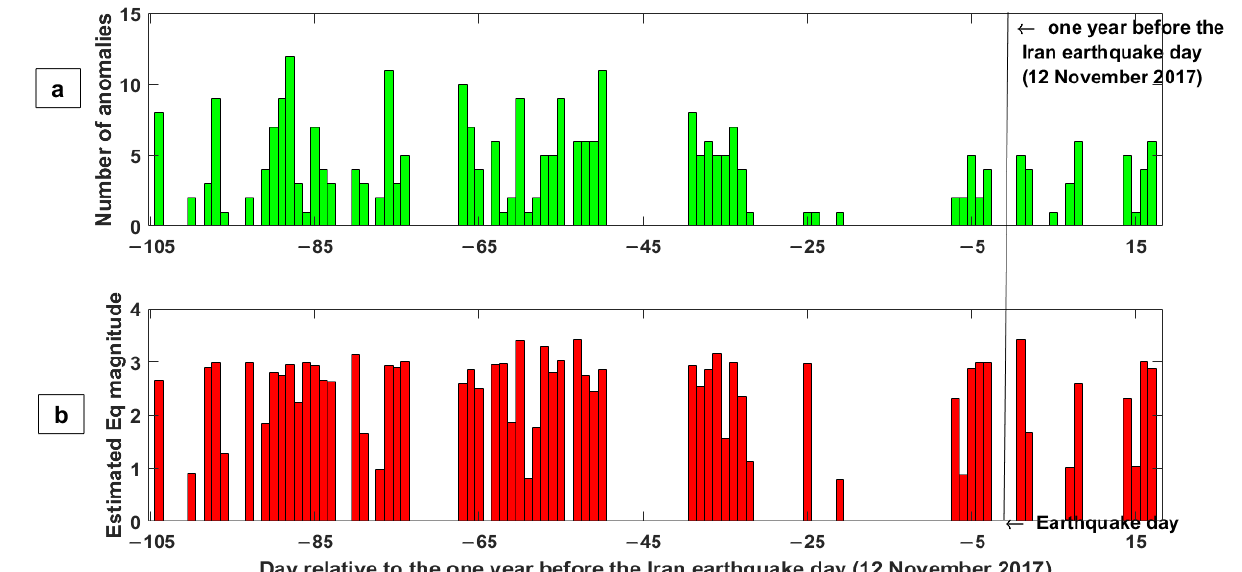
Figure 11. Validation analysis that was conducted in the same region as Figure 7 but from 1 August to 30 November 2016 for the same location. ( a ) the variations in the number of anomalies (green curve) and ( b ) the variations in the predicted earthquake magnitude (red